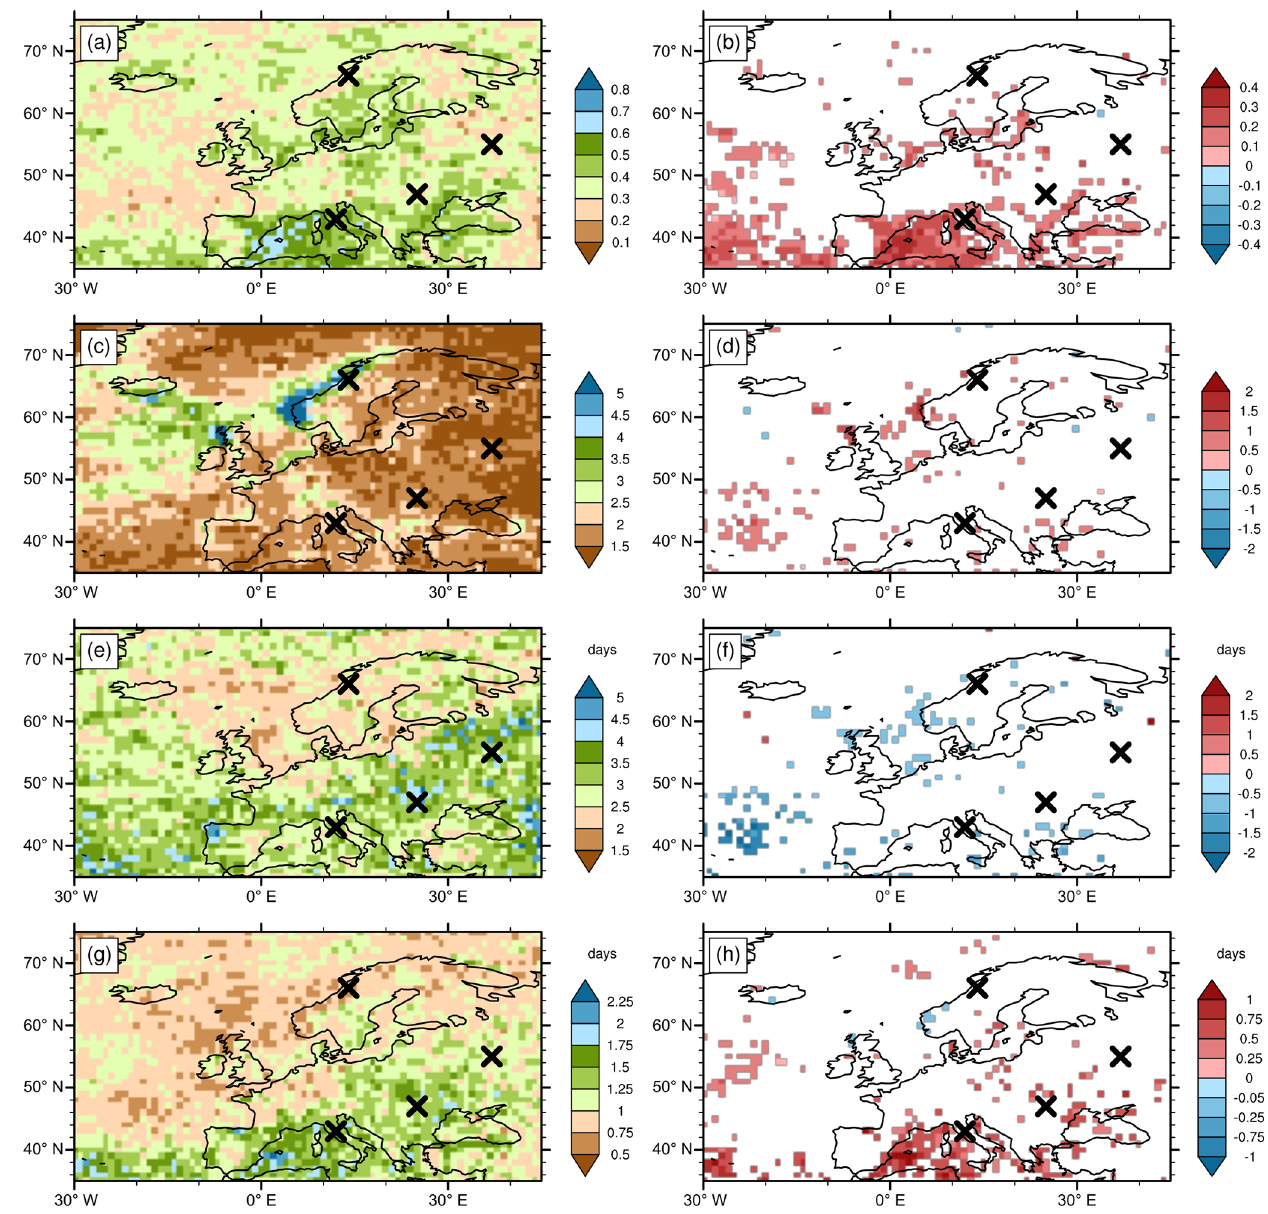
Figure 9. As Fig. 8 but for